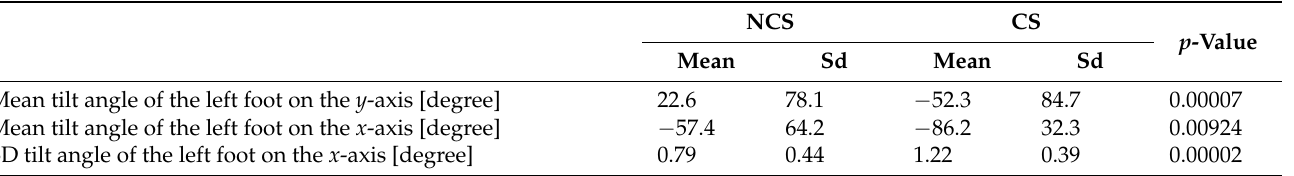
Table 9. Left foot characteristics of NCS and CS groups when the subject drove on the intersection on a public road.